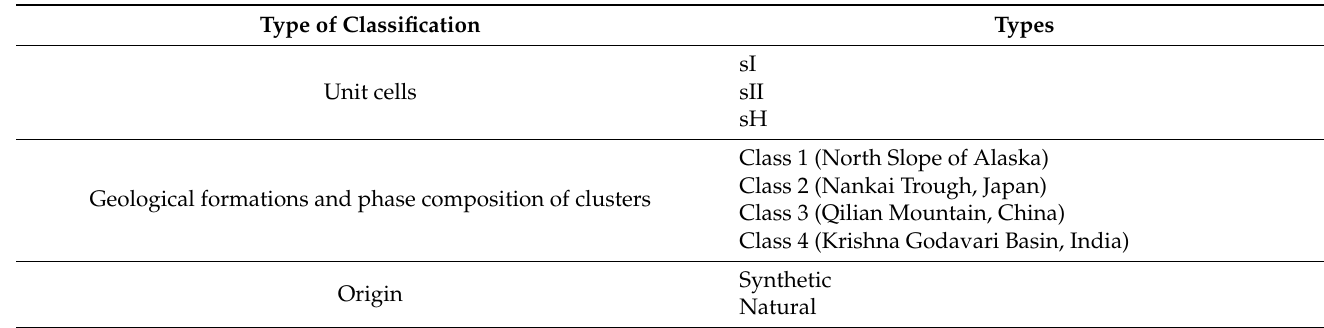
Table 1. Classification of gas hydrates.